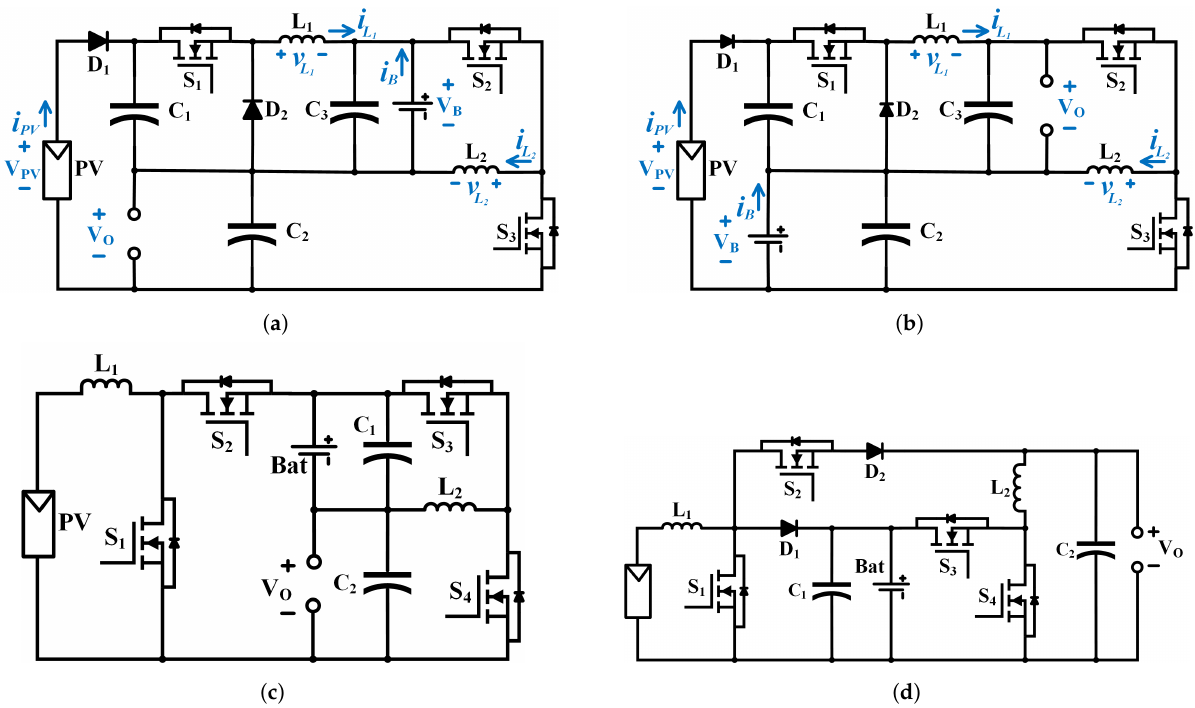
Figure 10. Circuit realisations of Type I-III-I configuration. ( a ) Type I-III-IA circuit realisation. ( b ) Type I-III-IB circuit realisation. ( c ) Type I-III-IC circuit realisation. ( d ) Type I-III-ID circuit realisation